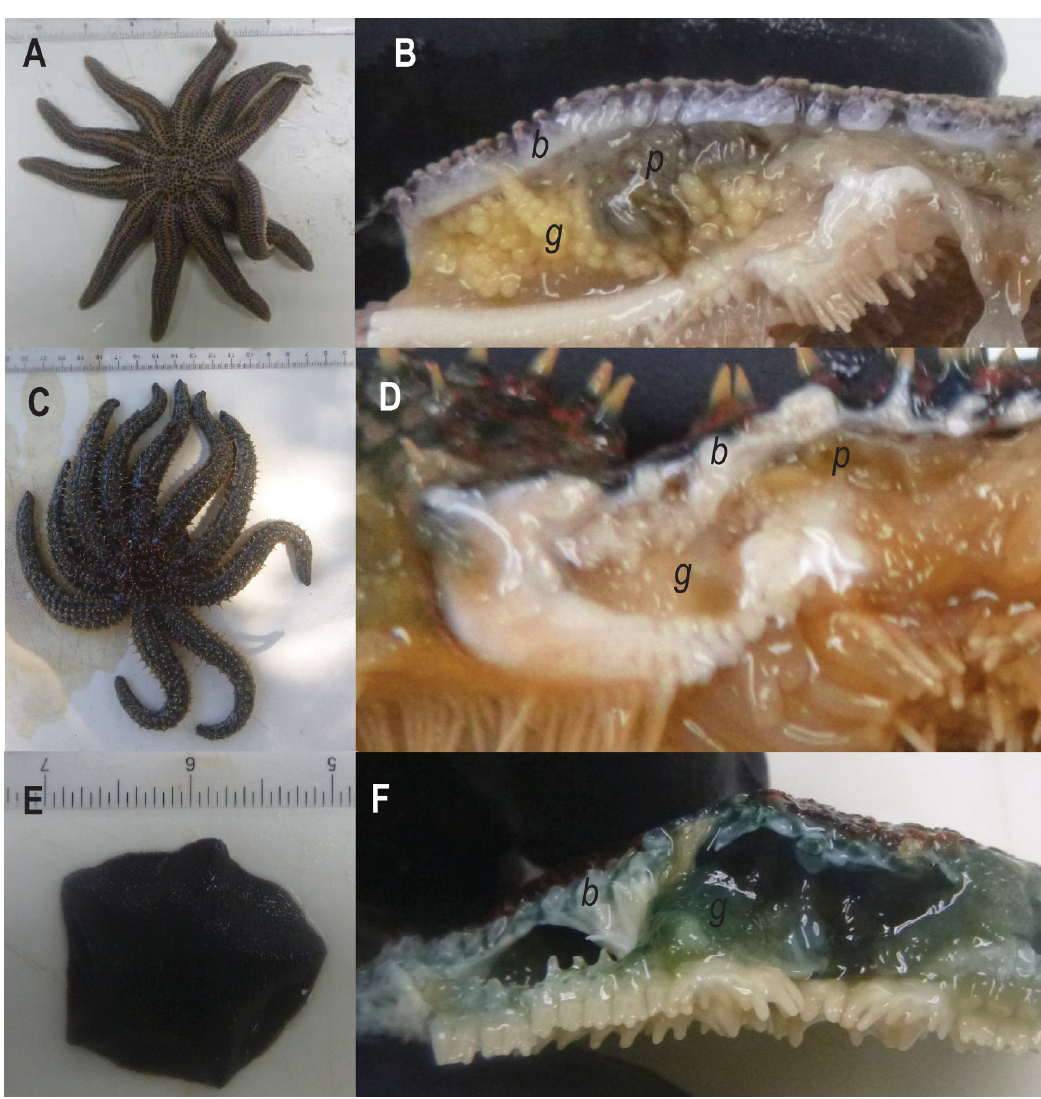
Fig 1. Sampled specimens of Stichaster australis (A-B), Coscinasterias muricata (C-D) and Patiriella regularis (E-F). Viral metagenomes were prepared from body wall ( b ) samples collected by biopsy punch. Additional specimens of gonad ( g ) and pyloric caeca ( p ) were collected for quantification of viral genotypes and the mesomycetozoan. https://doi.org/10.1371/journal.pone.0241026.g001 amplified using the TransPlex WTA2 (Sigma Aldrich) kit. We did not standardize template quantity (mass) of extracted RNA, but used 2 μ l extracted RNA in each amplification reaction.